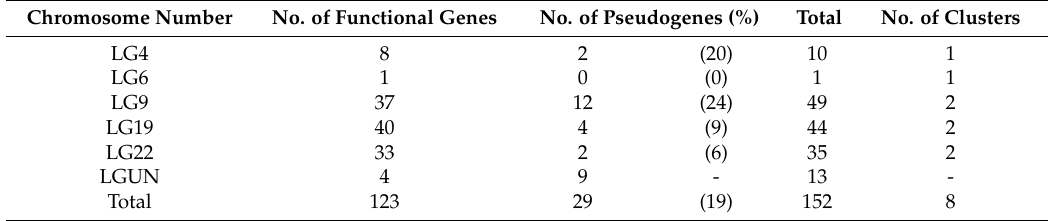
Table 1. A summary description of the olfactory receptor (OR) genes in Chinese